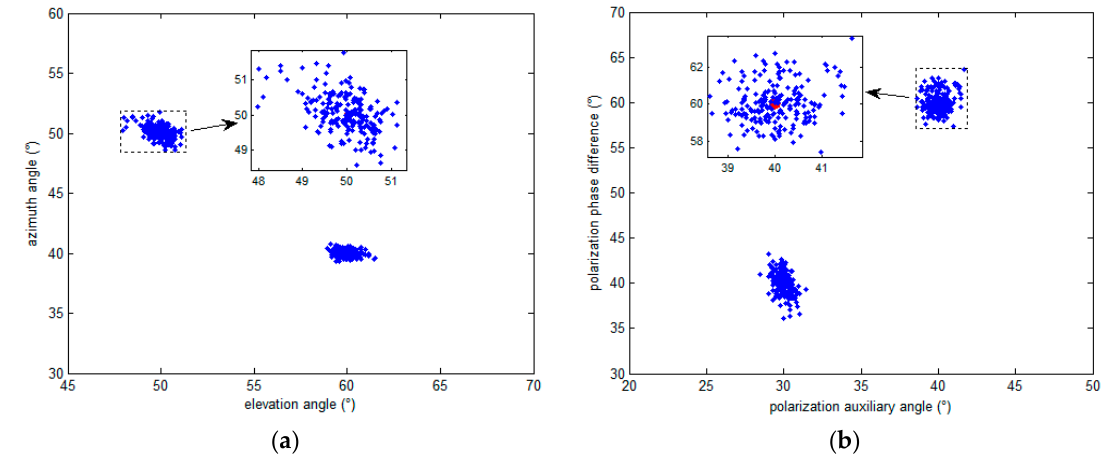
Figure 7. The simulation results distribution scatter diagram of proposed algorithm for ( a ) DOAs and ( b ) polarization parameters.